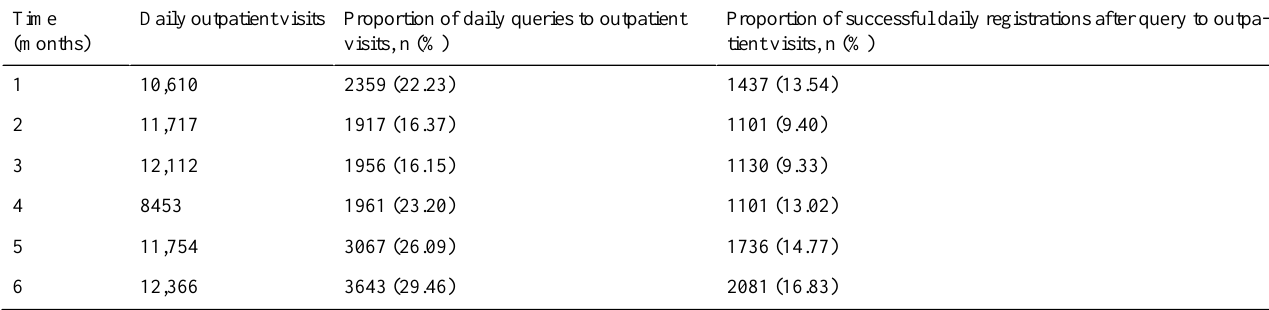
Table 1. Queries of smartphone-based triage, successful registrations after query, and proportions of outpatient visits. (%)Proportion of daily queries to outpatient (%)Daily outpatient visitsTime visits, n